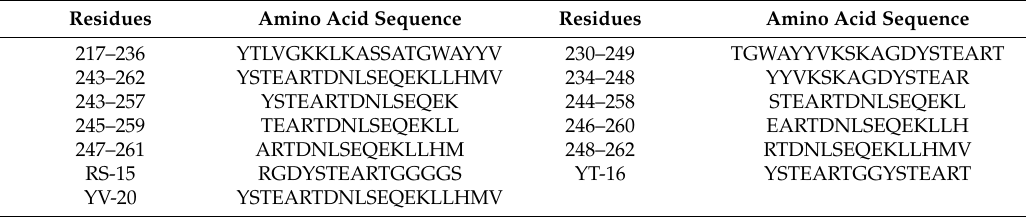
Table 2. Synthesized polypeptides based on the M protein of the transmissible gastroenteritis virus